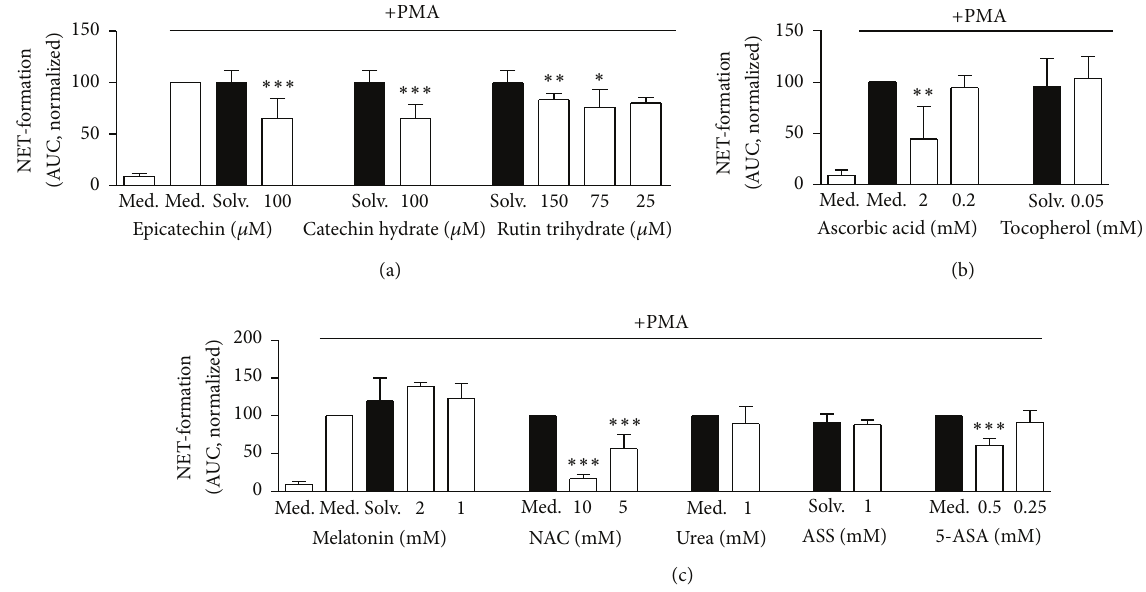
Figure 4: Influence of antioxidants on NET formation as measured by SYTOXgreen fluorescence. Neutrophils were preincubated with or without antioxidants for 30 min at 37 ∘ C. In the presence of 5 𝜇 M SYTOXgreen, NET formation was induced by 20 nM PMA and assessed for 5 h at 37 ∘ C. The NET formation of (a) the flavonoids epicatechin, catechin hydrate and rutin trihydrate, (b) the vitamins ascorbic acid, tocopherol,and(c)otherpharmaceuticalsubstancesmelatonin, N -acetyl-L-cytseine(NAC),urea,actetylsalicylicacid(ASS),5-aminosalicylic acid (5-ASA) was quantified by calculation of the area under the curve (AUC). Data were normalized to the sample of PMA-stimulated neutrophils without antioxidants (Med.). Data show mean ± SD from 4 ((c), melatonin), 5 ((b), (c)), 6 ((a), epicatechin, rutin trihydrate), or 8 ((a), catechin hydrate), independent experiments with 2 ((c), ASS, melatonin), 3 ((c), NAC) 4 ((a), epicatechin, rutin trihydrate), 5 ((b), (c) (urea, 5-ASA)) and 6 ((a), catechin hydrate) different donors. ∗∗∗ 𝑃 < 0.001 ; ∗∗ 𝑃 < 0.01 ; ∗ 𝑃 < 0.05 as compared to the PMA stimulated medium or solvent control (Med., Solv., black